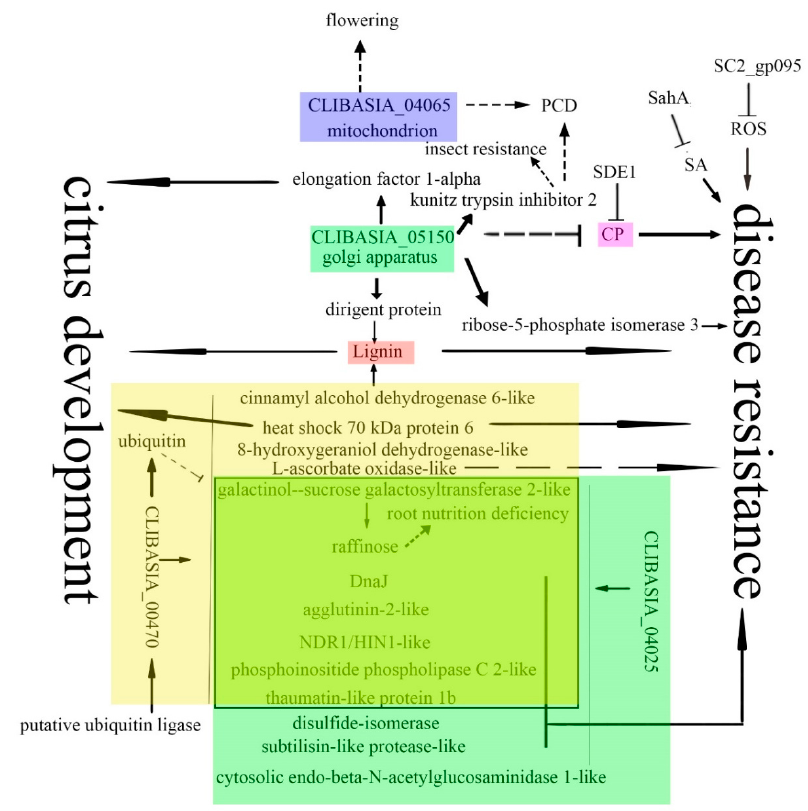
Figure 5. The hypothesis of the virulence mechanisms of Ca Las. It was reported previously that Ca Las inhibited citrus disease resistance by degradation defense signals SA (salicylic acid) and H 2 O 2 and inhibition CPs (cysteine protease). CLBASIA_05150 located in Golgi apparatus. It interacted with proteins involved in disease resistance, plant development, and protein synthesis. CLBASIA_05150 may interfere with the transportation of prey to the destination. CLBASIA_04025 and CLBASIA_00470 had the overlapping profiles of prey (indicated by the rectangular box). The identified prey included proteins involved in disease resistance, as well as plant development. CLBASIA_00470 may downregulate targets by ubiquitin-mediated protein degradation. CLIBASIA_04065 located in mitochondria. The prey may play a role in off-season flowering and programmed cell death (PCD). The solid line indicated the confirmed interaction or the known function of the protein. The dashed line indicated the speculation of interaction between proteins or the unknown function of proteins. The ‘T’ shape line indicated the inhibition function. Three isolates of XM_006474664 interaction with CLIBASIA_05150 were cysteine protease (CP), which interacted with another effector of Ca Las, SDE1 [34]. The rest of the isolates, XM_006471352, XM_025096339, XM_006441377, XM_006492080, and XM_006485840, were annotated as uncharacterized protein, ribose-5-phosphate isomerase 3, Kunitz trypsin inhibitor 2, dirigent protein 16, and elongation factor 1-alpha, respectively. Ribose-5-phosphate isomerase 3 (RPI3) catalyzes the reversible conversion of ribose-5-phosphate to ribulose 5-phosphate and plays a role in defense response to bacterium [56]. Kunitz trypsin inhibitor 1 from Arabidopsis antagonizes the cell death triggered by phytopathogens [57]. Kunitz trypsin inhibitor also functions in plant defense against